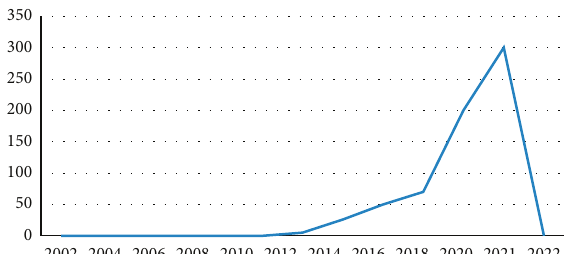
Figure 15: Article distribution by years for umbrella review articles.